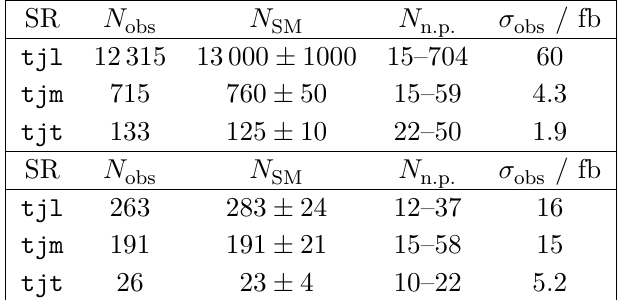
search [87] (top), and ATLAS dijet search from Run 2 [88] T